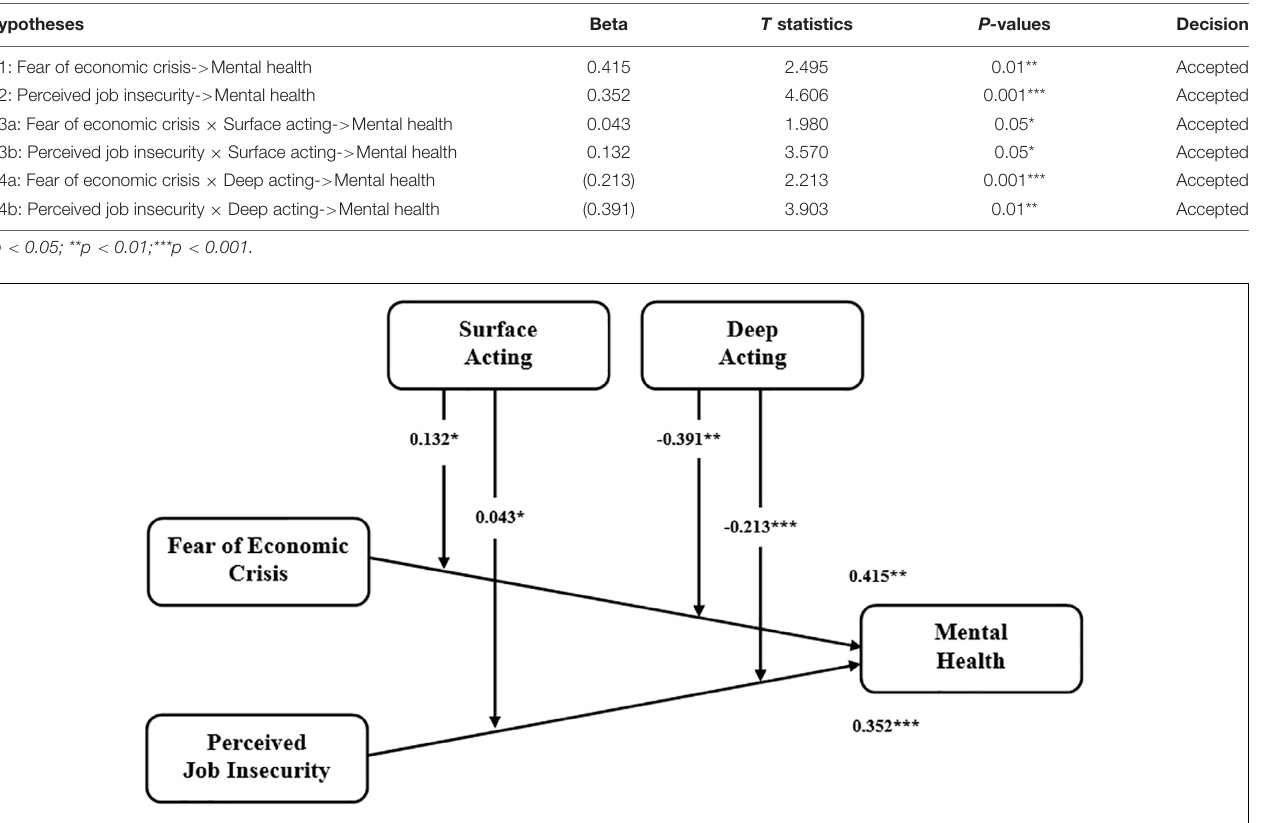
FIGURE 2 | Structural model with path estimates. * p < 0.05; ** p < 0.01; *** p <